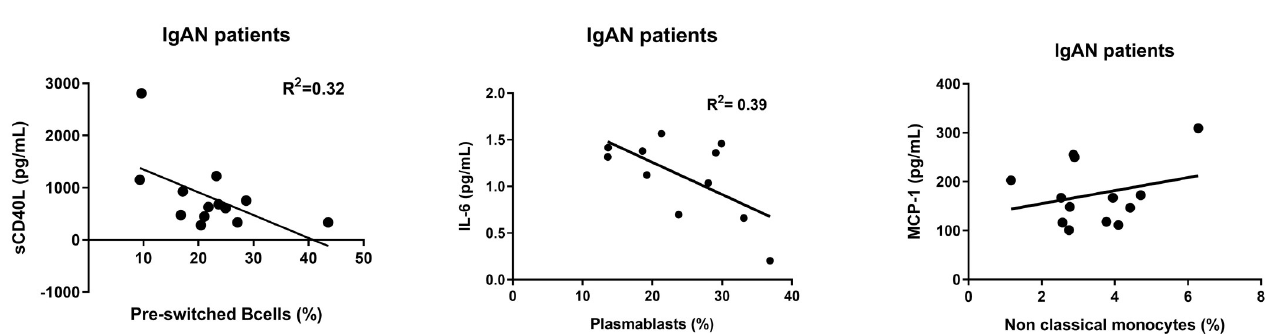
Fig 7. The relationship between cytokines and immune cell subtypes. The relationship between cytokines and immune cell subtypes in IgAN patients using linear regression test.